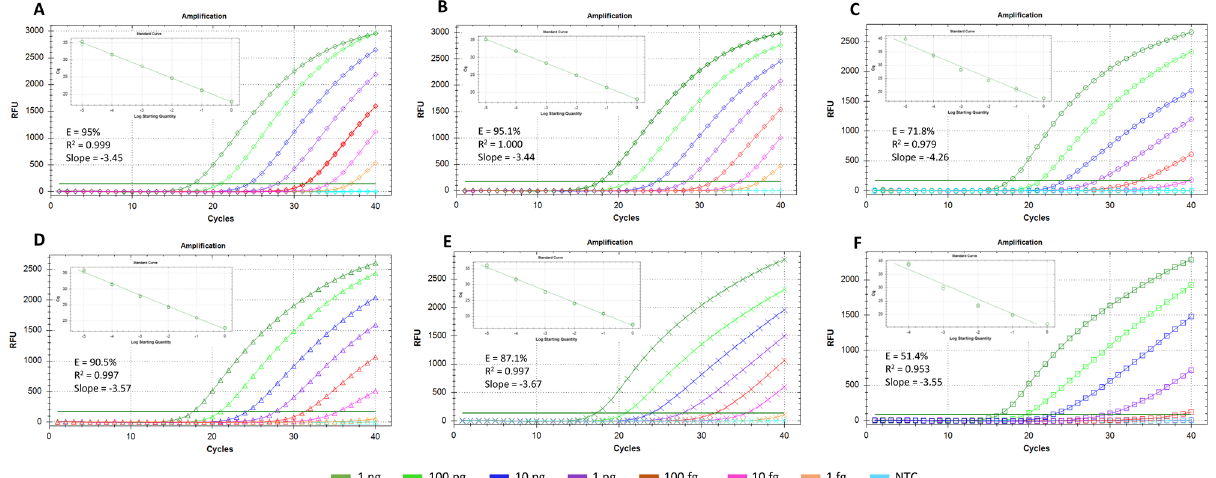
Figure 5. TaqMan real-time qPCR-based sensitivity assays with and without internal controls to predict detection limit of Rathayibacter toxicus . Bio-Rad SsoFast Probes Supermix was used for these sensitivity assays. ( A ) R. toxicus detection + No AIC; ( B ) R. toxicus detection spiked with 1 ng host DNA + No AIC; ( C ) R. toxicus detection + AIC-1 + No additional primer set was added (only R. toxicus specific primers were used); ( D ) R. toxicus detection + HIC with host DNA + No AIC; ( E ) R. toxicus detection + AIC-2 + HIC but no host DNA; ( F ) R. toxicus detection + AIC-2 + HIC with host DNA. Dilution color codes are provided at the bottom of the figure; NTC is non-template control (water).